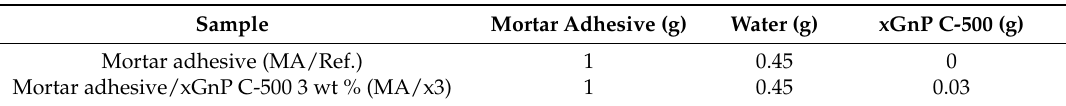
Table 1. Mixing ratios of